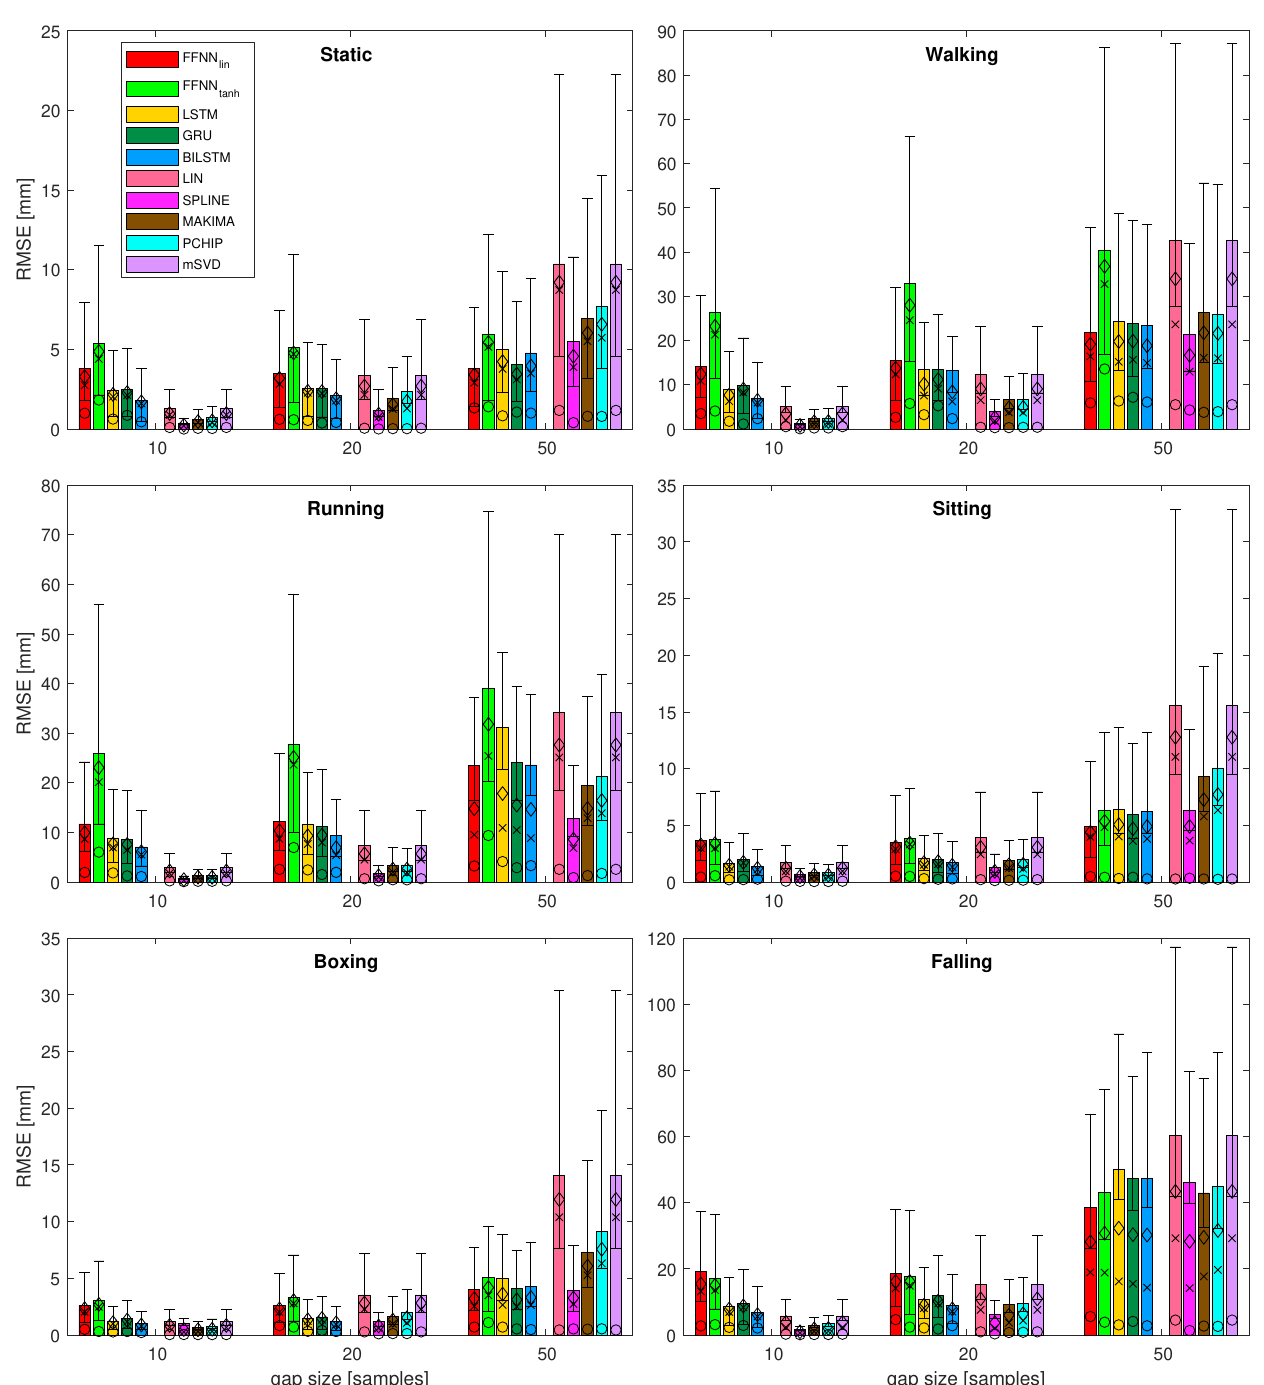
Figure 8. Results of the most of the quality measures for all the test sequences—zoomed variant for gaps 10, 20, and 50. Bars denote RMSE ; for RMSE k : (cid:5) denotes mean value, × denotes median, ◦ denotes mode, whiskers indicate IQR; standard deviation is not depicted